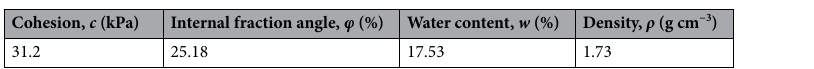
Table 1. Mechanical characteristics of elastic–plastic soils.